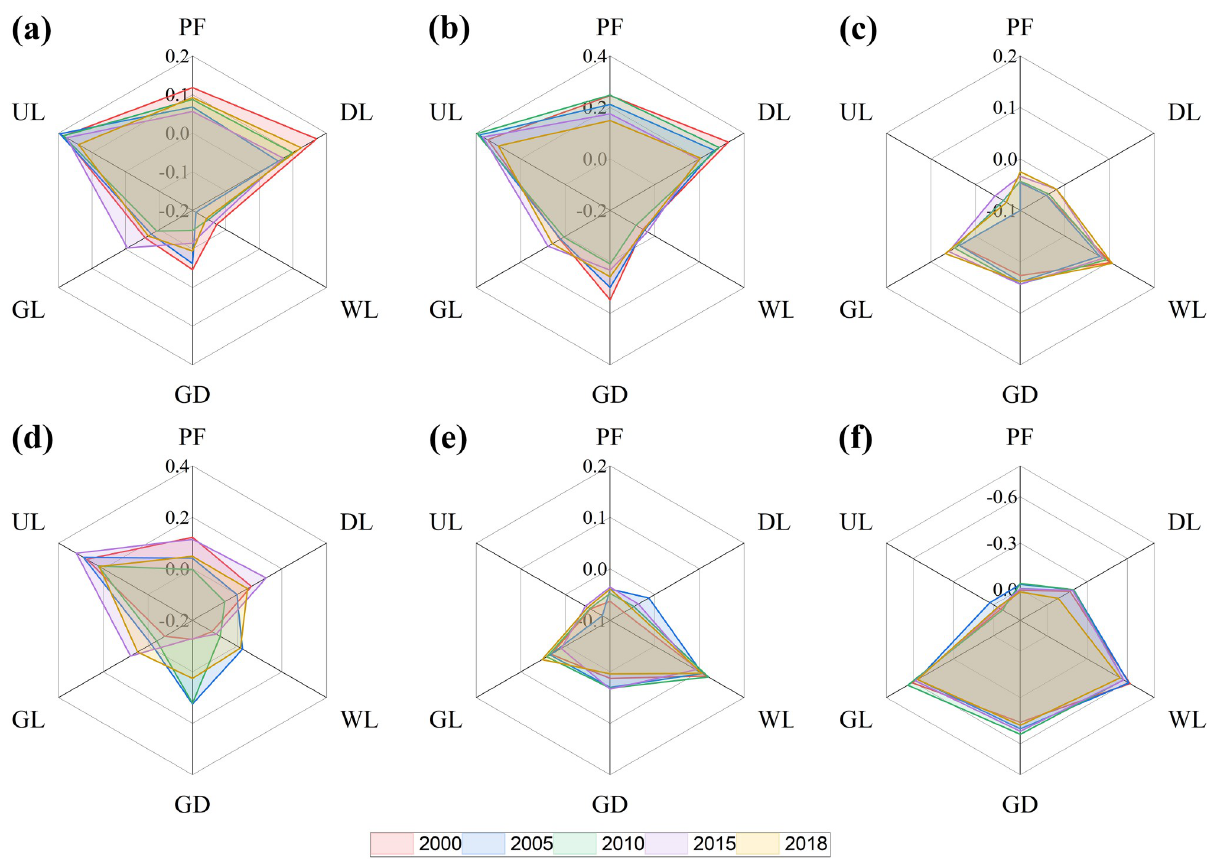
Fig 7. Effects of natural factors on soil erosion: (a) Elevation, (b) Slope, (c) Soil, (d) Rainfall, (e) Temperature, and (f) NDVI. PF—paddy field; DL —dry land; WL—woodland; GD—garden land; GL—grassland, and UL—unused